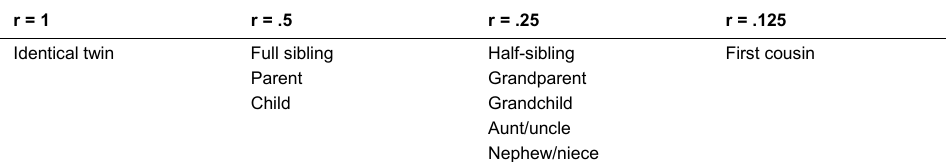
Table 1 : Genetic relatedness r between ego and various biological kin r = 1 r = .5 r = .25 r = .125 Identical